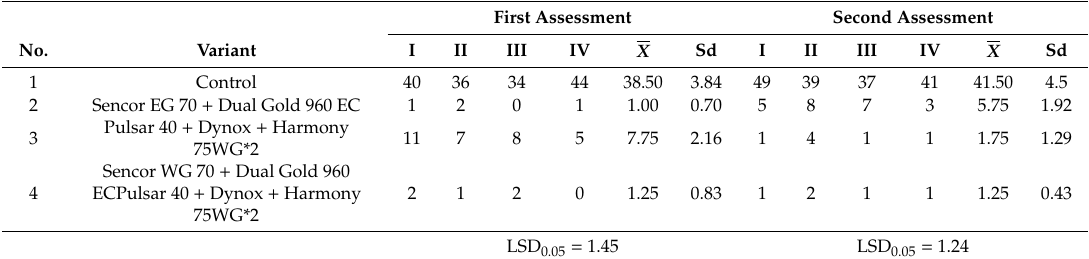
Table 5. Statistical analysis of the data after the first and the second assessment at Pobeda. First